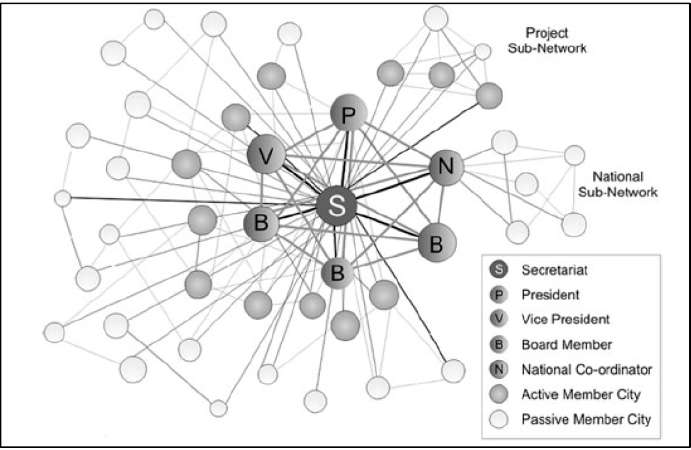
Figure 4. Structure of transnational municipal networks [49].